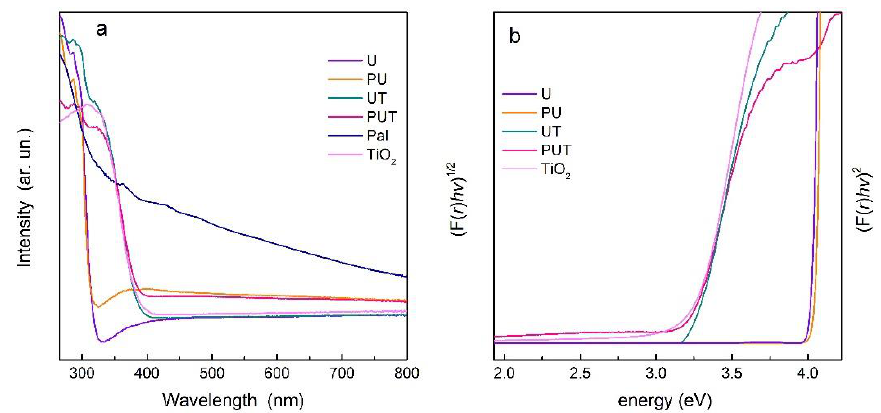
Figure 4. UV/Vis absorption spectra ( a ) and plots used to estimate the bandgap energies ( b ).